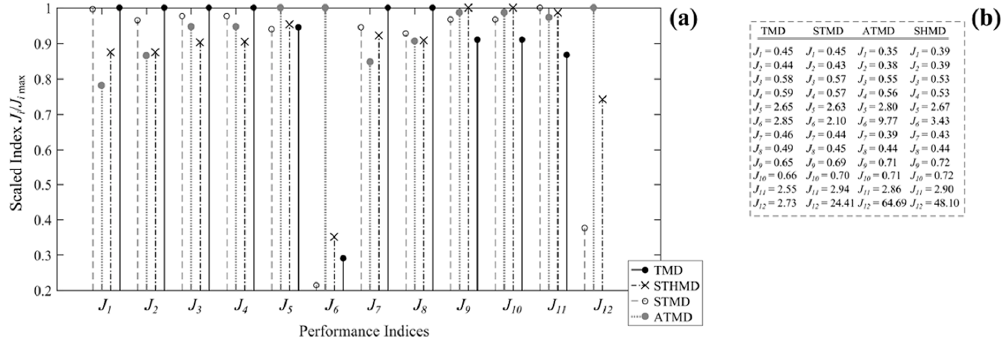
Figure 13. ( a ) Normalised; and ( b ) non ‐ normalised performance indices (lower index indicates better performance).